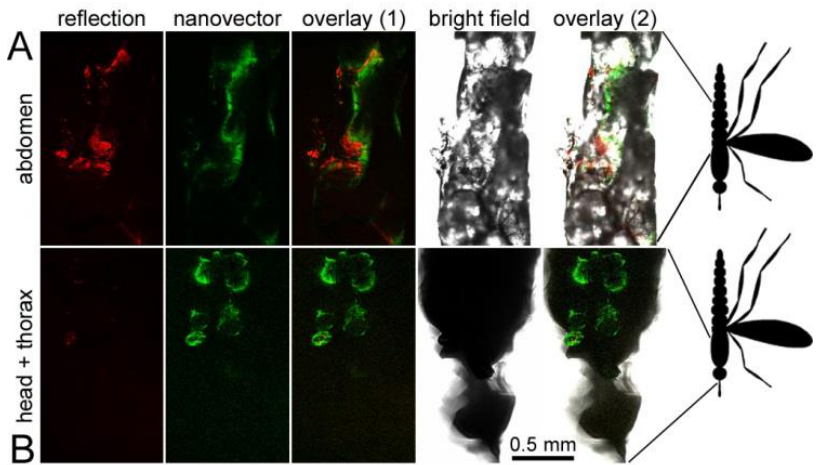
Figure 8. Direct delivery of PAAs to Anopheles . Newly hatched A. atroparvus were fed fluorescein-labeled ISA1 incorporated in their sugar meal. Confocal fluorescence microscopy indicated the presence of fluorescein signal ( A ) in the midgut (first day post-feeding) and ( B ) in a region of the thorax consistent with salivary gland location (three days post-feeding). In red is shown the reflection of excitation light on the cuticle of the insect.